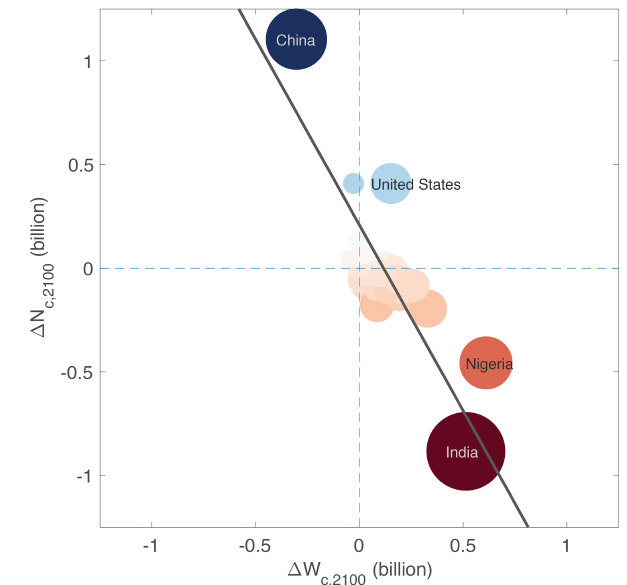
Figure 2. Country-level projections for population increase in the year 2100 relative to the year 2005 ( (cid:49)W c, 2100 = W c, 2100 − W c, 2005 , x axis) and the number of people for whom climate change is projected to provide additional incentive to migrate under RCP8.5 ( (cid:49)N c, 2100 ; y axis). The areas of the circles are proportional to the year 2100 population. The color scale is as per Fig. 1b. The line shows the population-weighted linear trend. Negative values on the y axis indicate additional incentive to emigrate; positive values in- dicate countries that increase in relative attractiveness. The results hold all factors constant, except for climate and country-level popu- lation. The data used to produce this figure are provided in Table